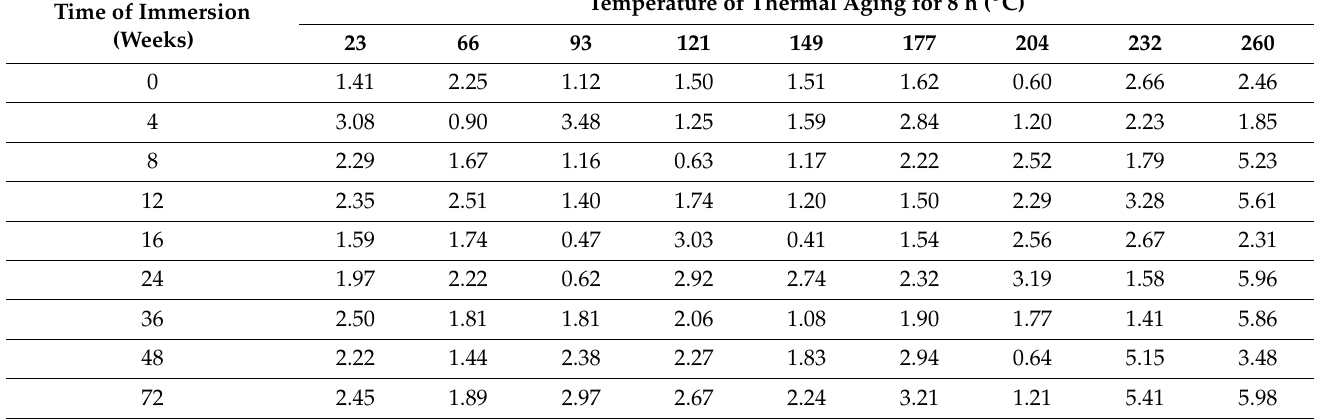
Table 1. Standard deviations of short beam shear strength for specimens immersed in deionized water after regimes of thermal